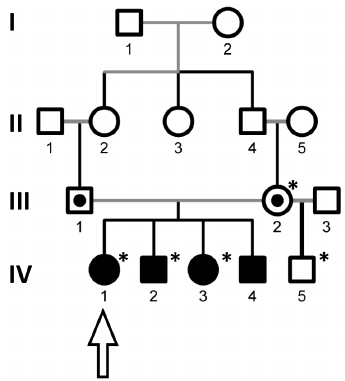
Figure 1. Four generations (I - IV) of Brazilian family are shown. Solid symbols indicate the affected individuals; dotted circles—married cousins, heterozygous obligate carriers; open symbols— unaffected individuals; asterisks—individuals for whom genetic analysis was performed; arrow— patient for whom whole-genome sequencing was